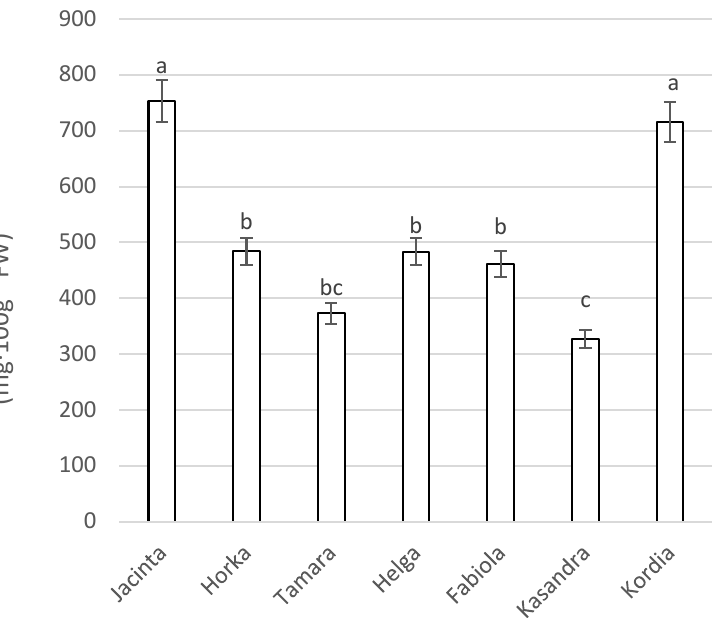
Figure 2. Polyphenol content, depending on cultivar. Values with different letters are significantly different.